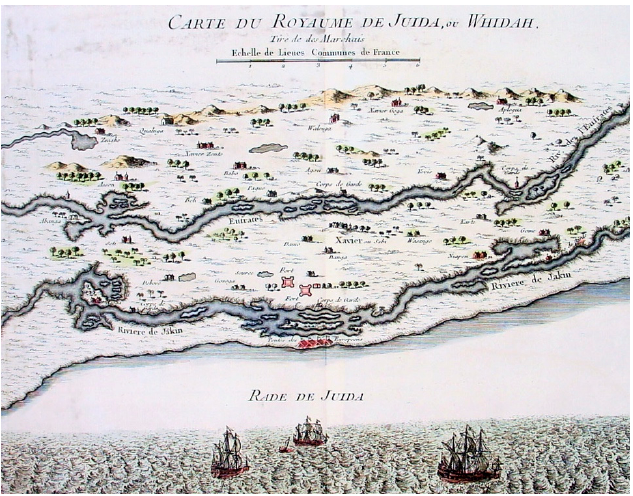
Figure 10. “Carte du Royaume de Juida or Whidah,” from Abbé Provost’s Histoire Générale des Voyages (1746–1759).